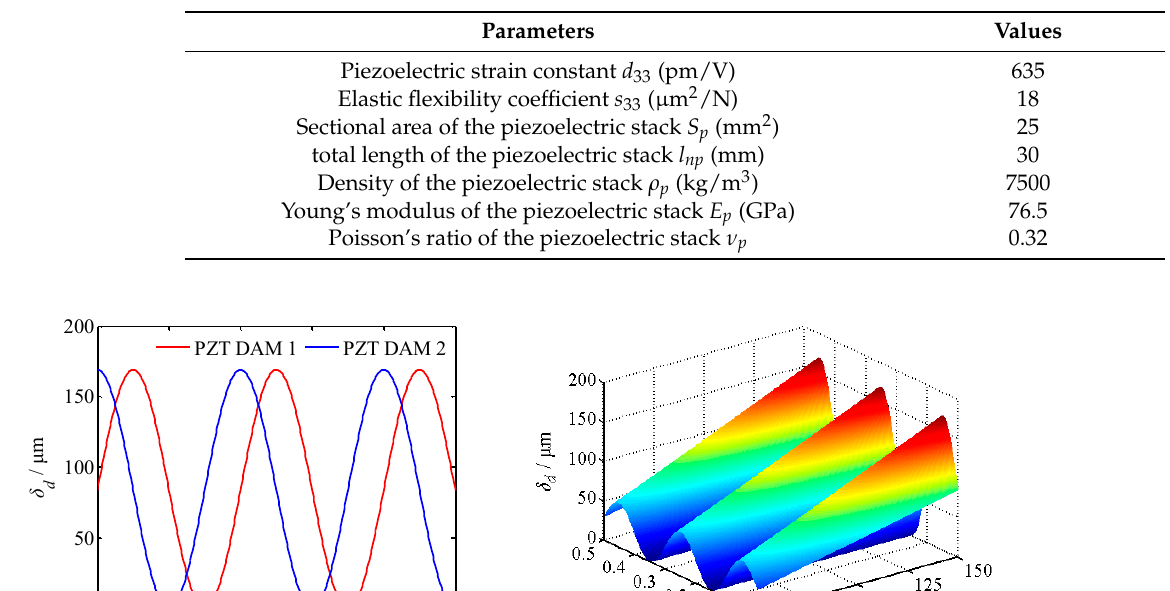
Table 1. Physical parameters of piezoelectric stack.